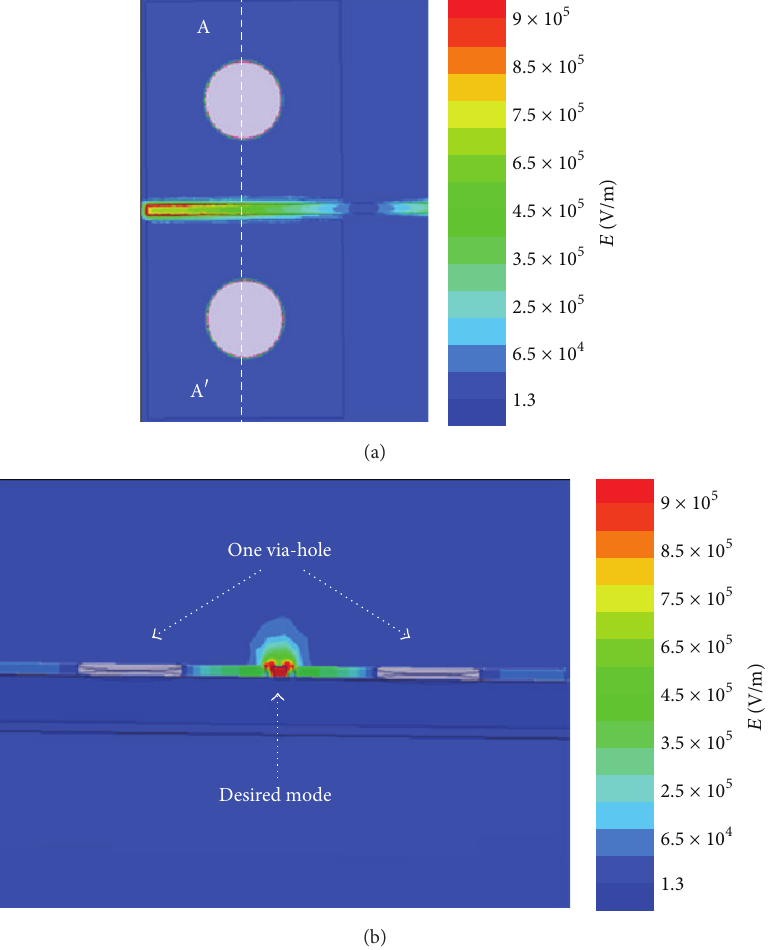
Figure 7: Electrical field distribution in the GCPW-MS transition with one via-hole at 40 GHz (a) in the top view and (b) in the transverse section of the plane A-A 󸀠